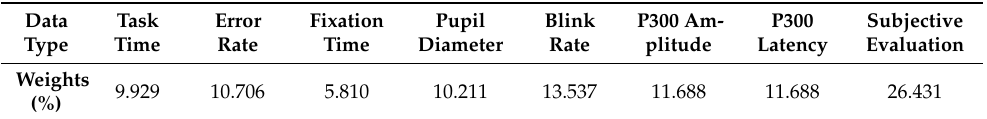
Table 22. Evaluation indicator weights.